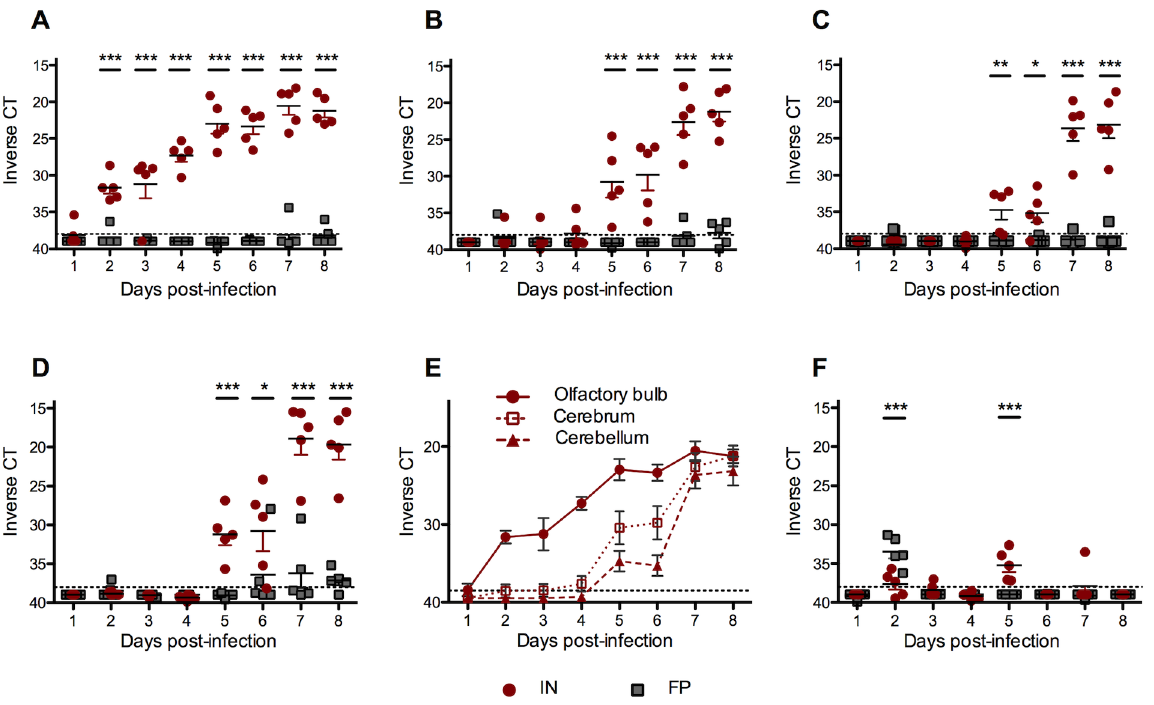
Figure 2. In IN-inoculated mice, virus replication was first apparent in the olfactory bulb 2 dpi and spread caudally, whereas FP- inoculated mice had low levels of virus RNA present in the brainstem at late time points. Viral RNA loads from 100 mg of (A) olfactory bulb, (B) cerebrum, (C) cerebellum, and (D) brainstem were quantified by RVFV qRT-PCR and the CT was displayed on an inverted scale. CT cut-off of 40 noted by gray dashed line. (E) The temporal pattern of virus spread in the CNS of IN-inoculated mice. (F) Viral RNA loads from sciatic nerve. Data represents vRNA loads of 5 mice per group each day.